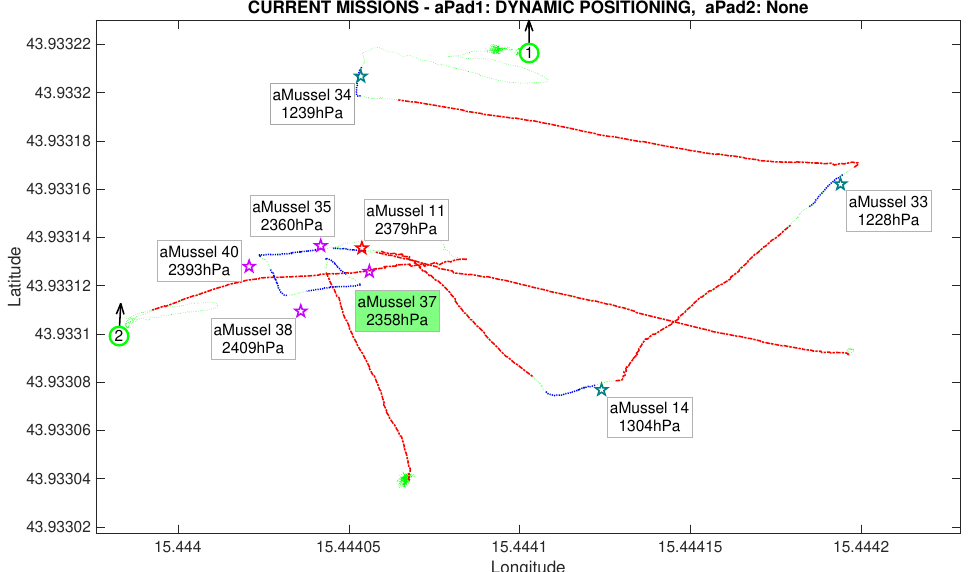
Figure 17. Outlier validation started in the Anoxia scenario experiment results from the deployment phase, reconstructed and replayed from recorded vehicle data—Biograd na Moru testbed.